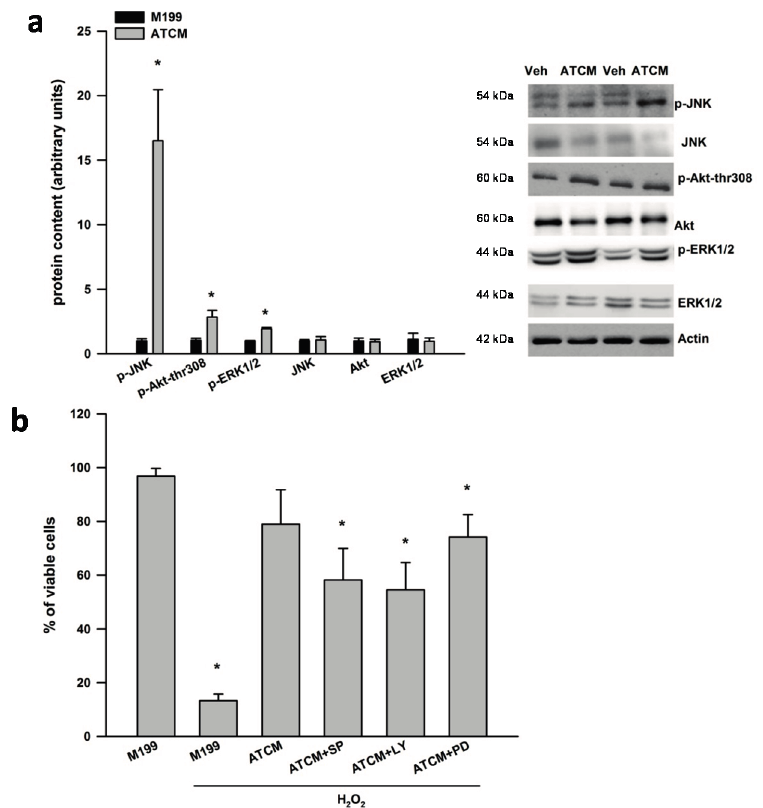
Figure 2. ERK1/2, JNK and PI3K are involved in the protective effects of lean ATCM against H 2 O 2 induced neurotoxicity. ( a ) Adipose tissue conditioned media (ATCM) from lean subjects was applied to SH-SY5Y neuronal cells for 1 h and the phosphorylation of JNK, Akt at threonine 308, and ERK1/2 was measured by western blotting. Phosphorylated signaling proteins are expressed relative to respective total protein and the ATCM condition was compared to vehicle (veh) treated well and ( b ) Adipose tissue conditioned media (ATCM) from lean subjects was applied to SH-SY5Y neuronal cells for 24 h in the presence of 800 µM H 2 O 2 . Chemical inhibition of JNK with SP600125 (5 µM), PI3-K with LY29400 (20 µM) and ERK with PD98059 (25 µM) partially inhibited the neuroprotective effects of ATCM in SH-SY5Y cells under oxidative stress conditions. Representative western blots are shown to the right of the quantified data in panel A. All cell culture experiments were repeated on two separate passages of cells with ATCM from three different subjects ( n = 6). * p < 0.05 compared to M199